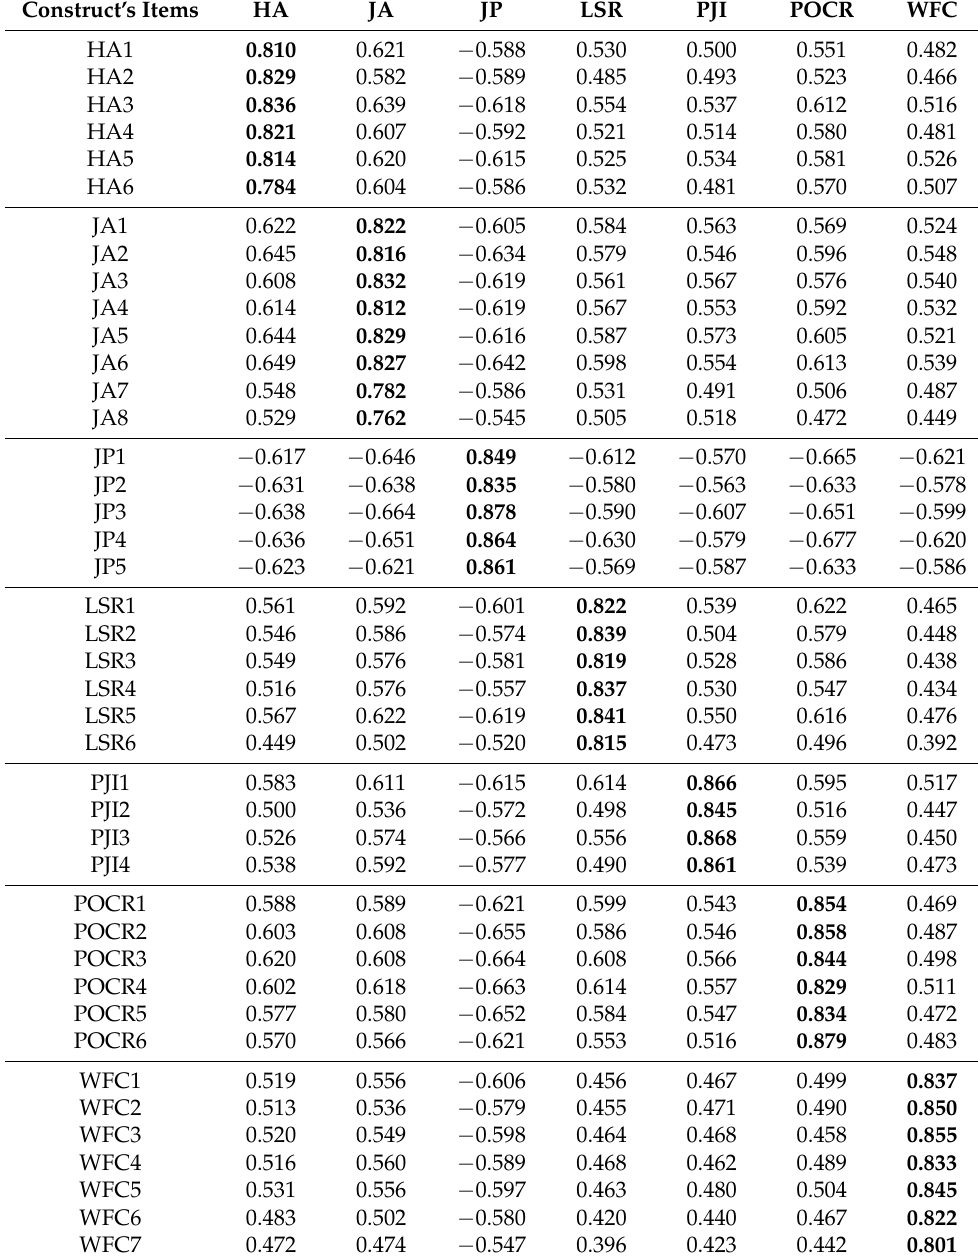
Table 5. Discriminant-validity analysis